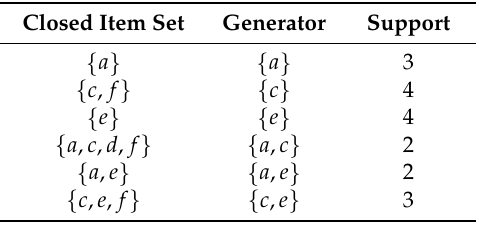
Table 3. Closed Frequent Itemsets of